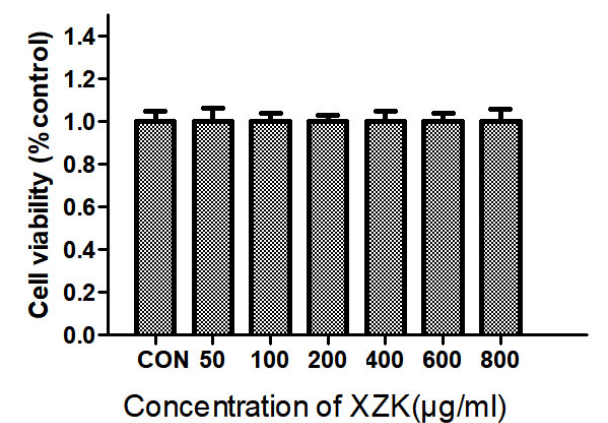
FIGURE 3 - The cytotoxicity of XZK in HepG2 cells using the MTT assay.